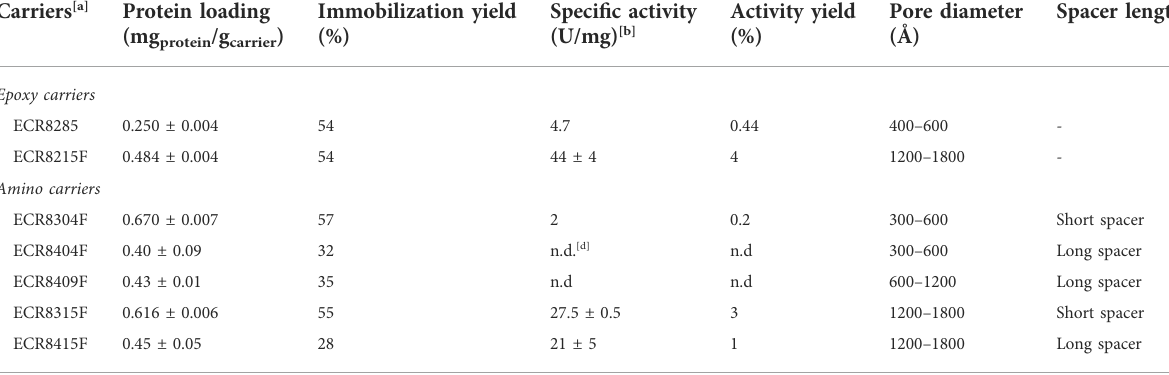
TABLE 1 Screening results obtained for the covalent immobilization of Aae UPO PaDa-I. Carriers